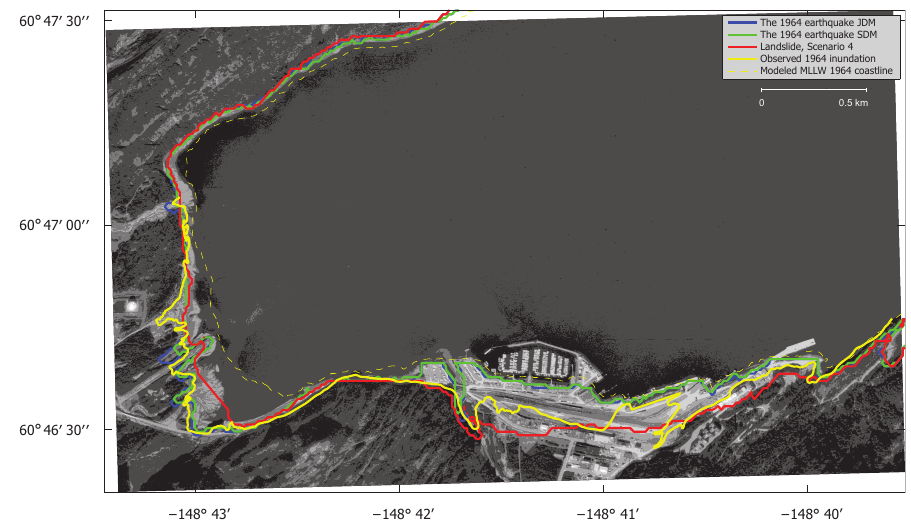
Fig. 13. Observed and modeled 1964 inundation caused by tectonic and landslide-generated waves. The yellow line represents the observed inundation after the 1964 tsunami. The modeled MLLW shoreline before the earthquake is shown by a dashed yellow line. The DEM height corresponds to the pre-earthquake sea level